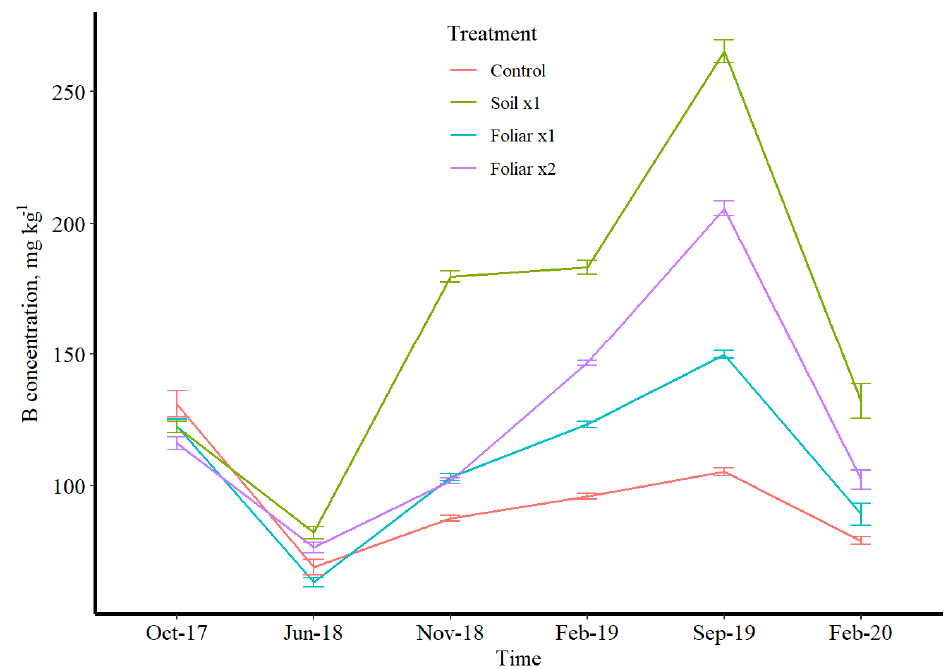
Figure 4. B leaf concentration over time in different micronutrient treatments (control, soil × 1. foliar × 1, and foliar × 2). B, Mn, and Zn rates were 1.12, 10.08, and 5.60 kg ha − 1 . Lines represent data with 95% confidence intervals.